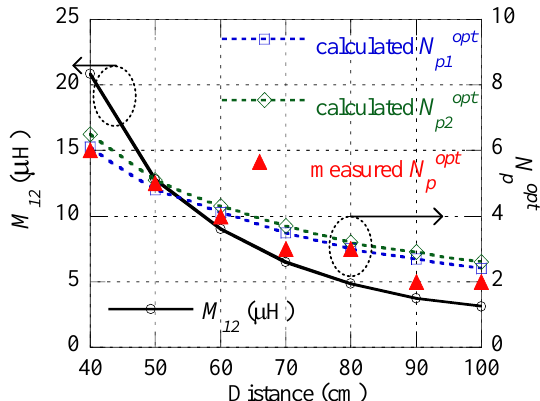
Figure 7. Measured mutual inductance and calculated and measured numbers of turns in the primary coils of the Tx and Rx transformers for optimal impedance matching condition according to the distance.